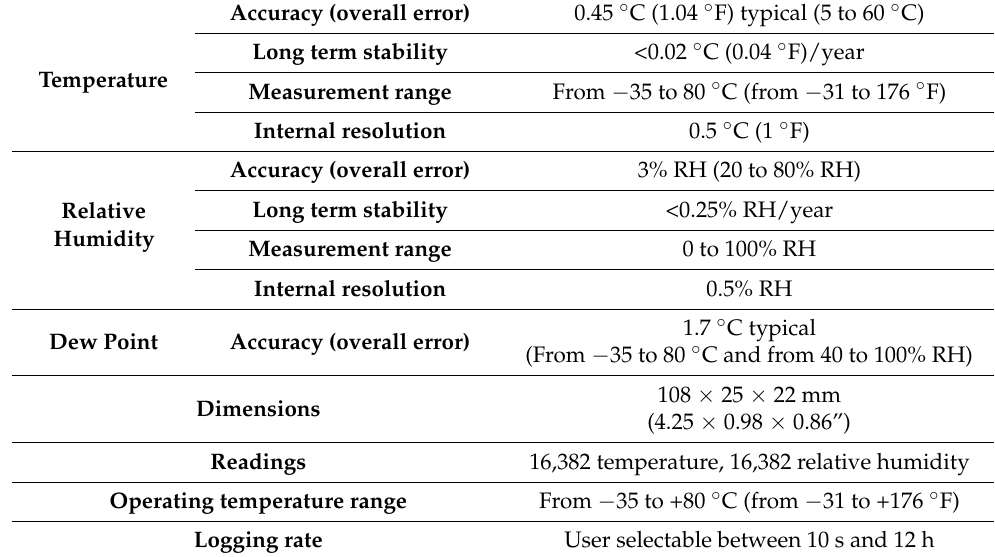
Table 3. Datalogger data